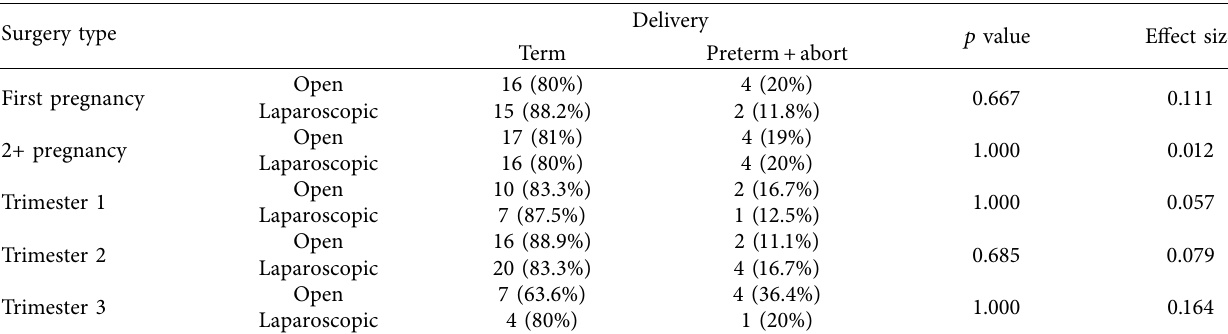
Table 6: Relationship between the first pregnancy and multiple pregnancies and trimester-based surgical methods on delivery. Surgery